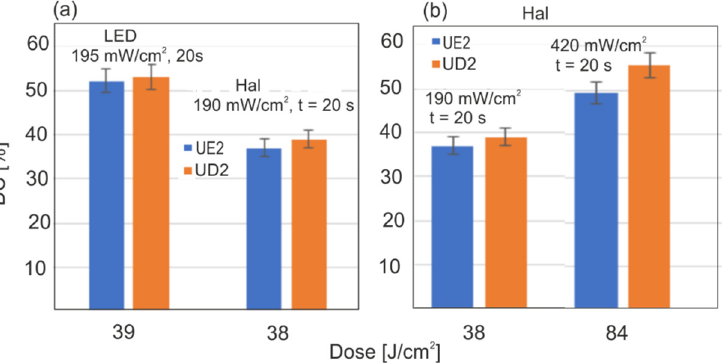
Figure 12. Influences of light source and dose on conversion degree 20 min after irradiation: ( a ) Hal and LED with the same dose; ( b ) different doses with the Hal source.